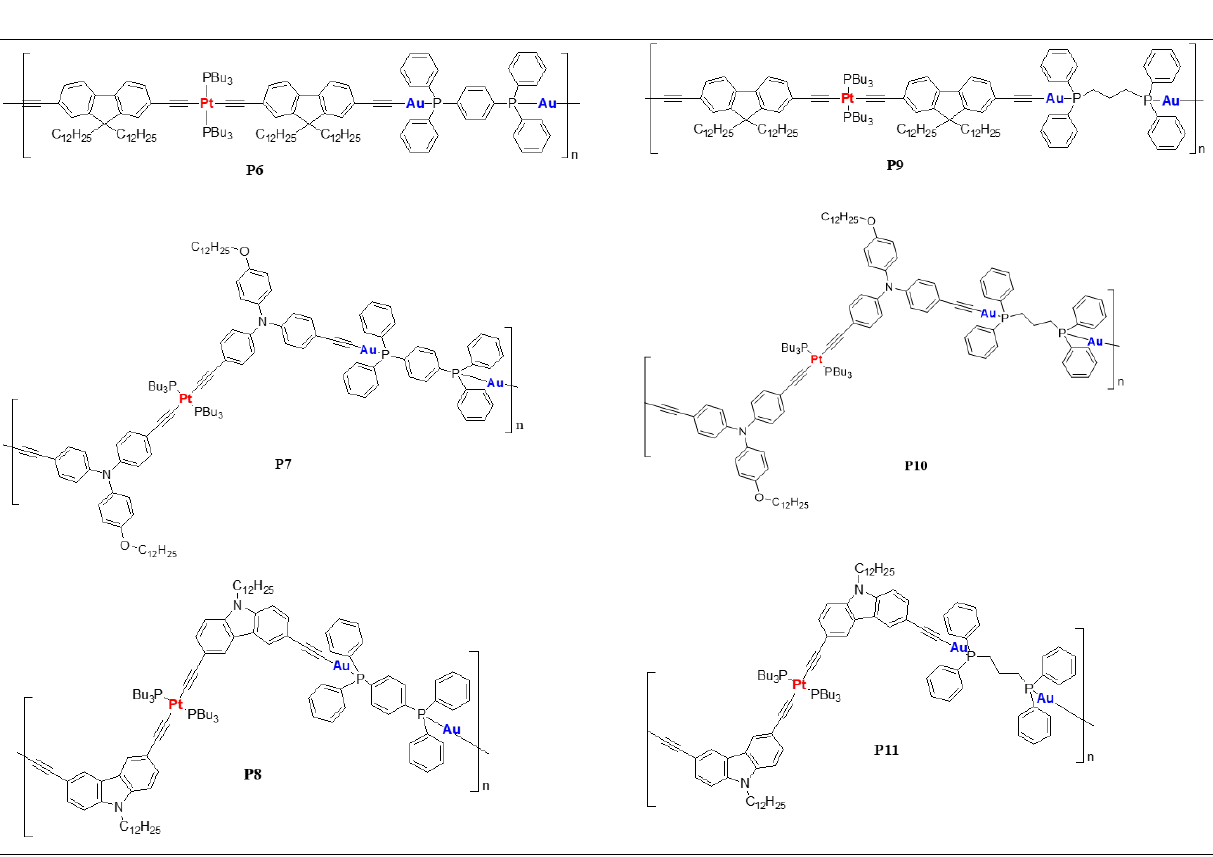
Figure 5. Heterometallic Au(I) – Pt(II) poly(metalla-ynes) ( P6 – P11 ) reported by Wong et al. [22].